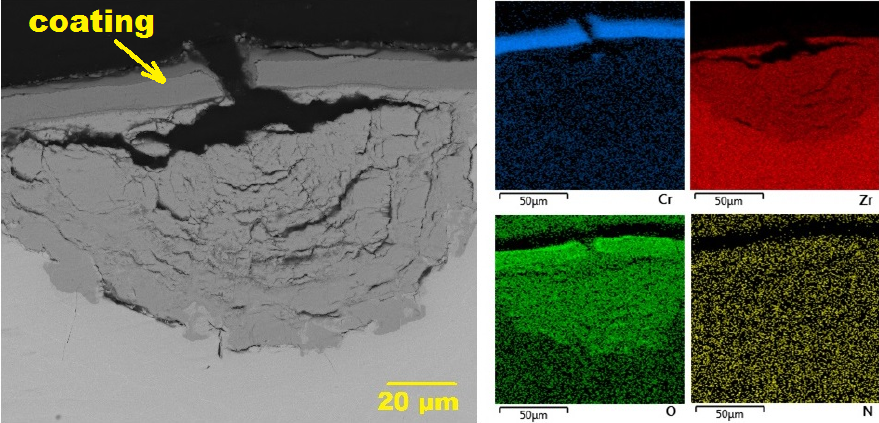
Figure 5. Optical images of the cross-section of the ZrO 2 /Cr-100 sample after 50 thermal cycles at different magnification: ( a )—×50; ( b )—×200.